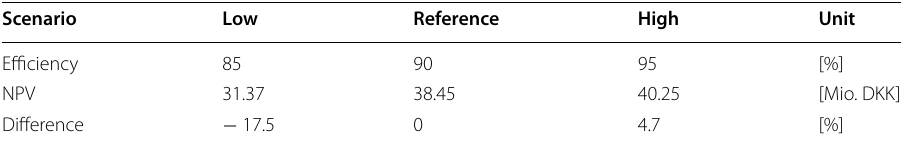
Table 4 Technical performance indicator